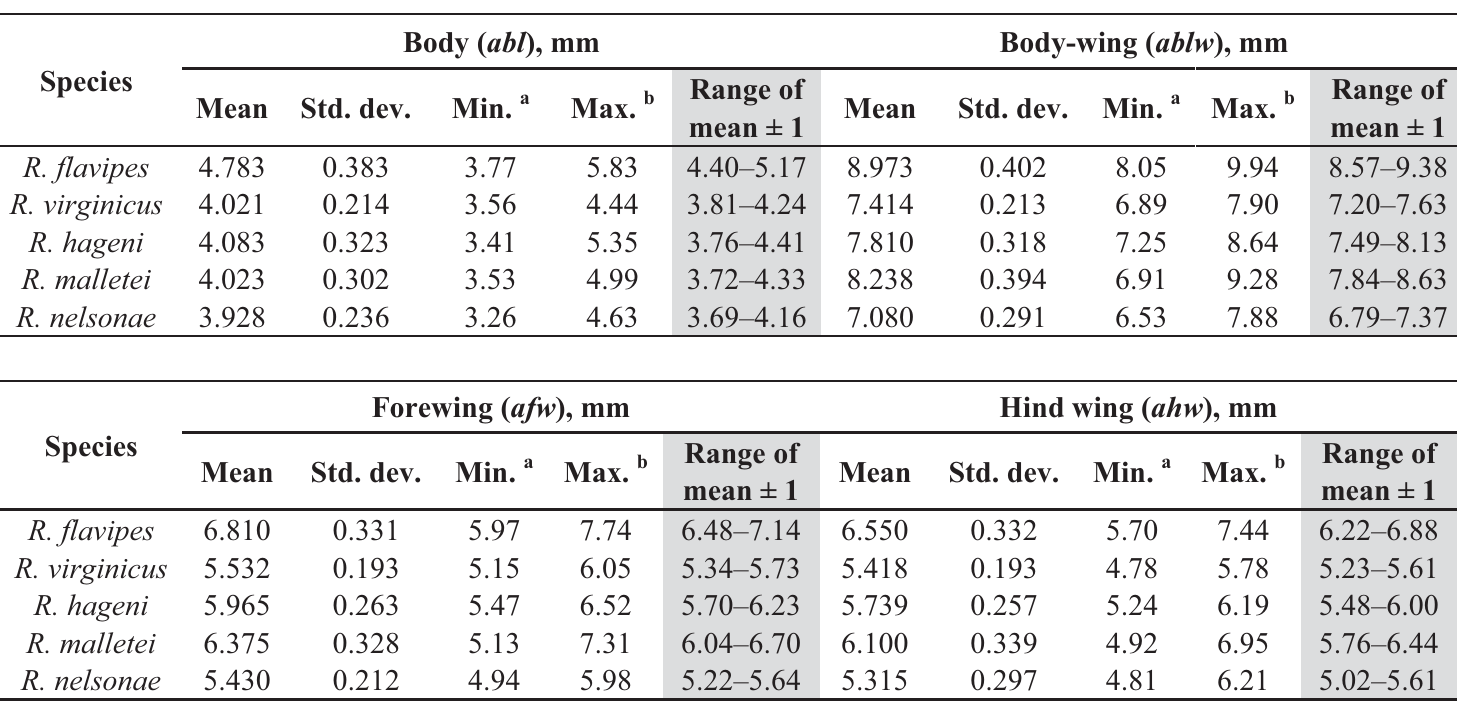
Table 4b. List of alate characters measured by species showing mean, standard deviation, range of values and range of mean ± one std. dev.